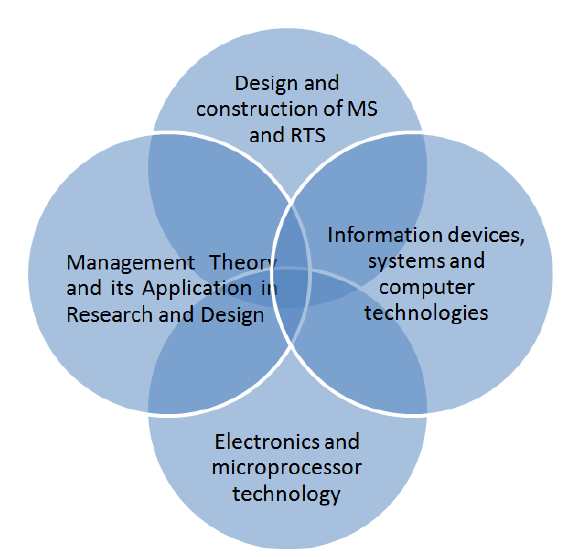
Fig. 2. Main components of the training of